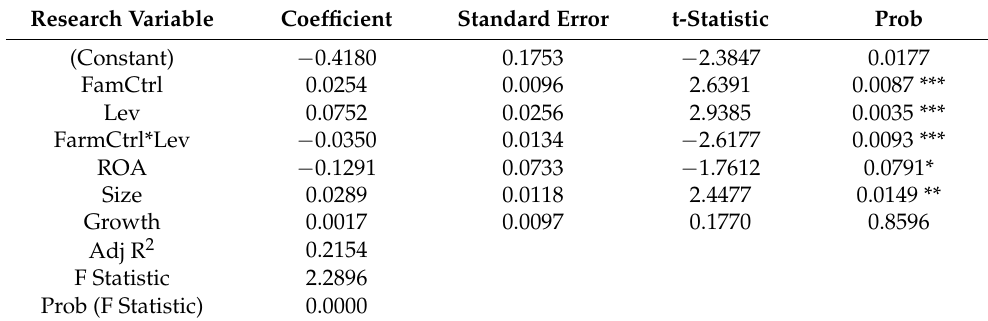
Table 2. Regression